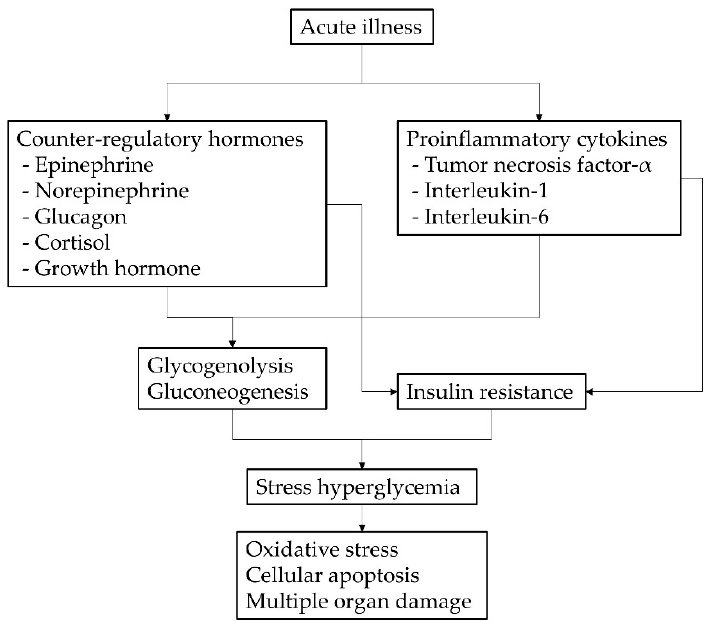
Figure 3. Pathophysiology of stress hyperglycemia in children with acute illness.